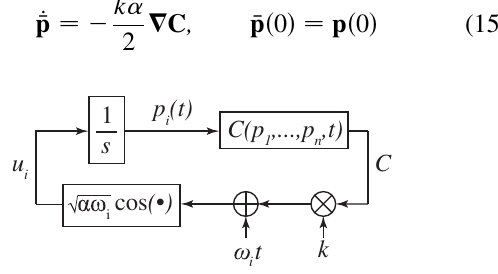
R t u (cid:5) Þ d(cid:5) i ð 0